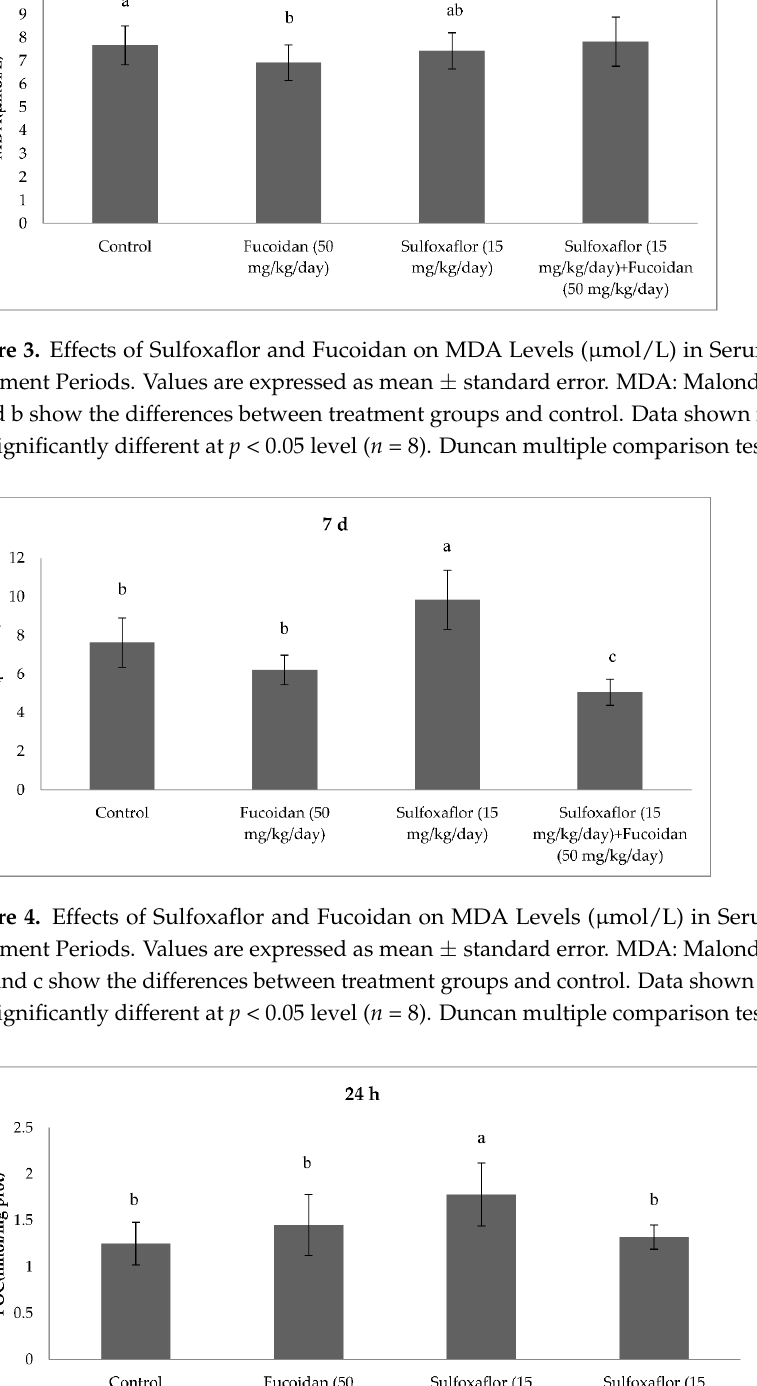
Figure 5. Effects of Sulfoxaflor and Fucoidan on POC Levels (nmol/mg protein) in Serum of Mice at 24-h Treatment Periods. Values are expressed as mean ± standard error. POC: Protein carbonyl. Letters a and b show the differences between treatment groups and control. Data shown in different letters are significantly different at p < 0.05 level ( n = 8). Duncan multiple comparison tests were used.